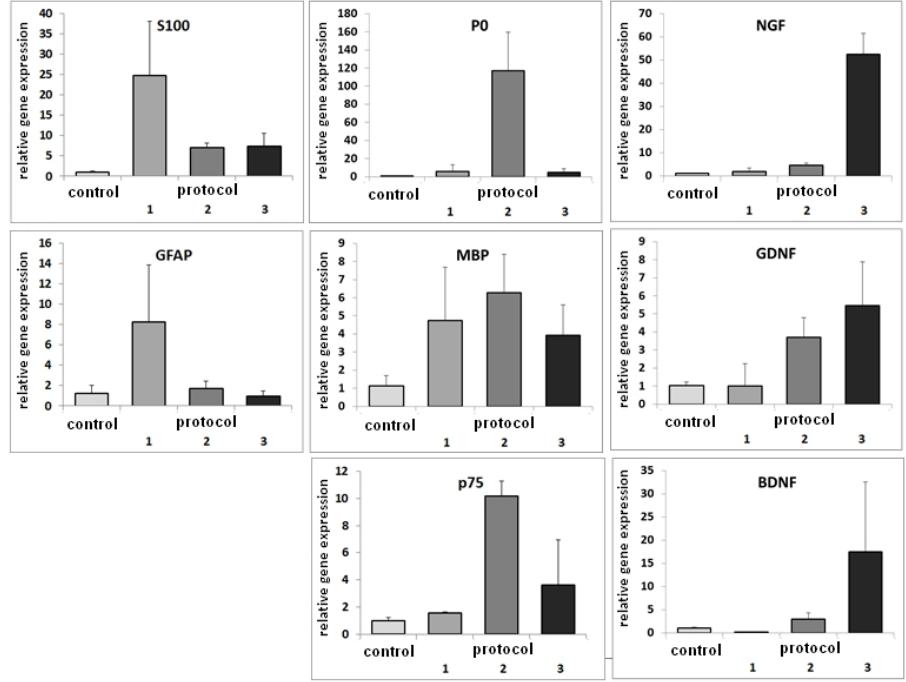
Figure 2. Relative gene expressions after neural differentiation of ASCs with three different proto- cols. ASCs differentiated with Protocol 1 express the general glial markers S100 and GFAP. ASCs differentiated with Protocol 2 express the markers of the myelinating Schwann cells P0, MBP, and p75. ASCs differentiated with Protocol 3 express the neurotrophins and neurotrophic factors NGF, GDNF, and BDNF.